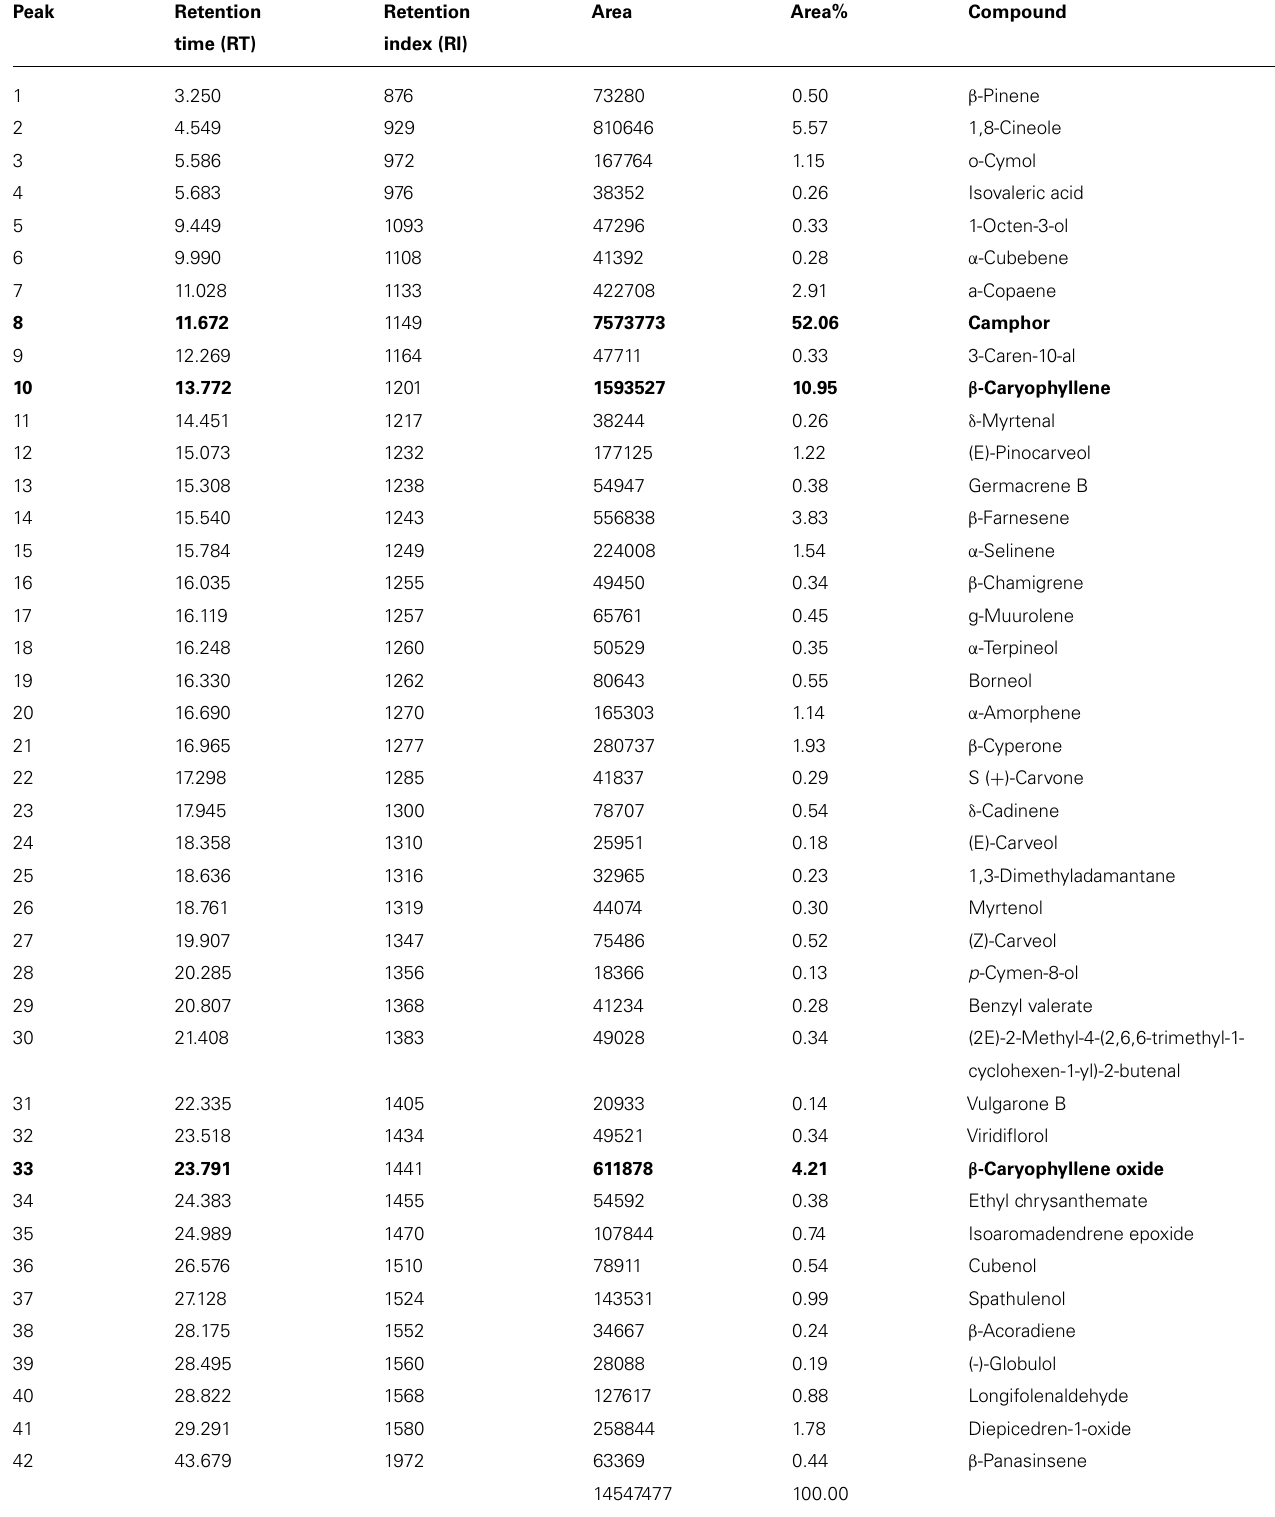
Table 1 | Phytochemical fingerprinting ofAALEO by GC-MS.